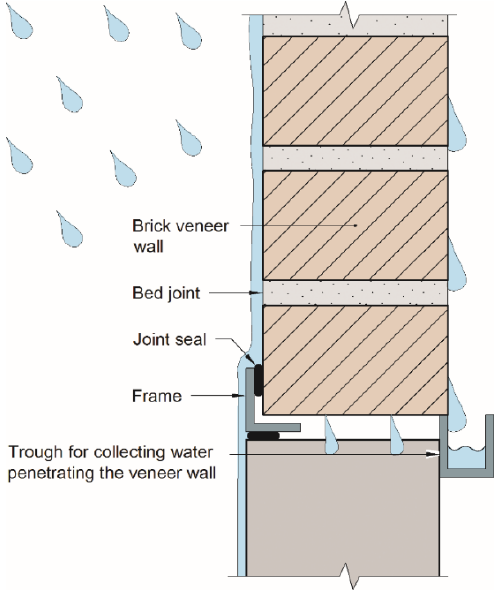
Figure 3. Collecting water, principal cross-section.